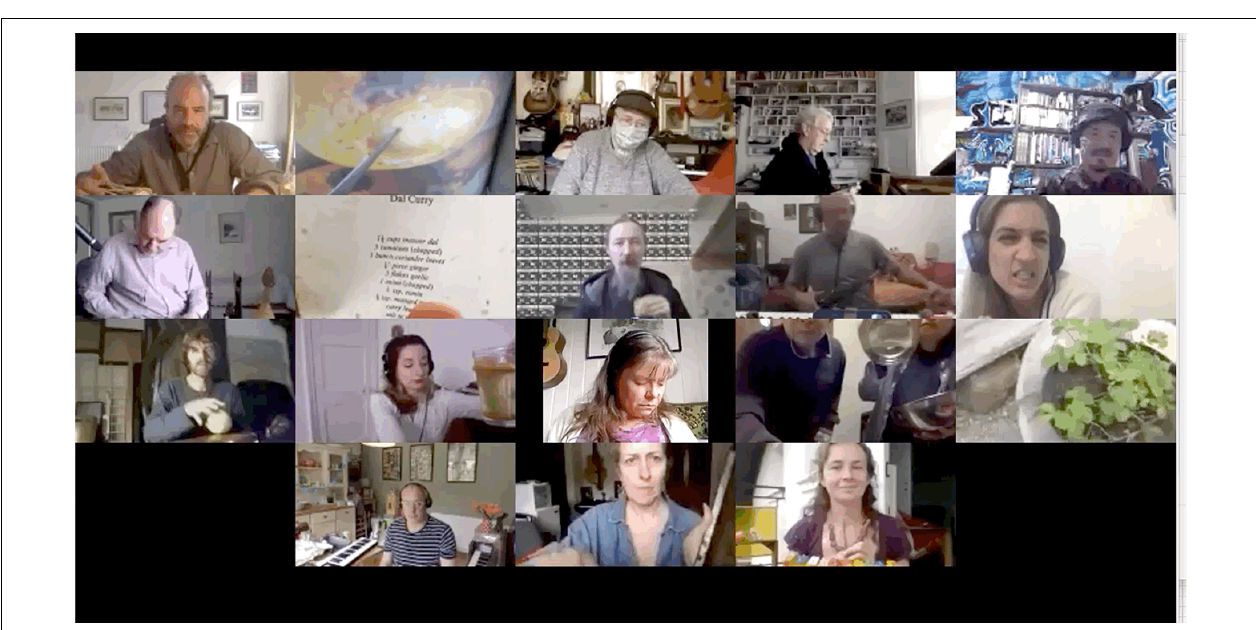
FIGURE 9 | Showing objects/home/instruments 1. The Gif version, highlighting musicians’ movement, can be found in the Supplementary Material